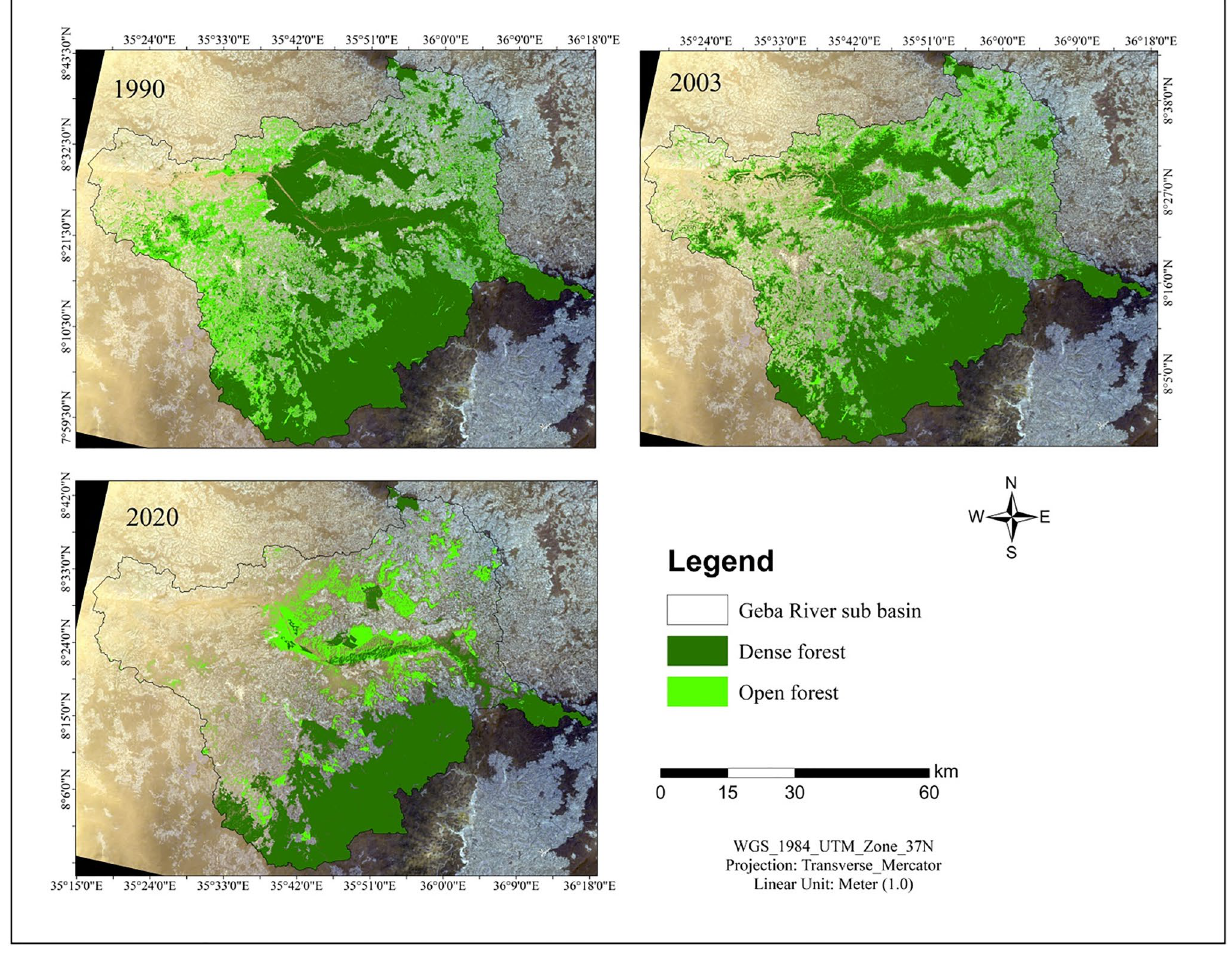
Fig. 4 Forest cover map of 1990, 2003 and 2020